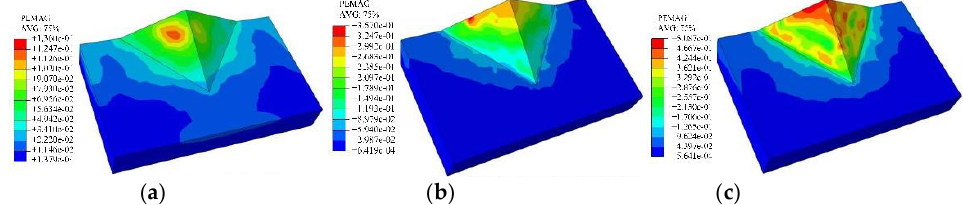
Figure 12. The plastic zone cloud map of ridge slope under different slope heights; (a) H =10m; (b) H =20m; (c) H =30m. ( b ) H = 20 m; ( c ) H = 30